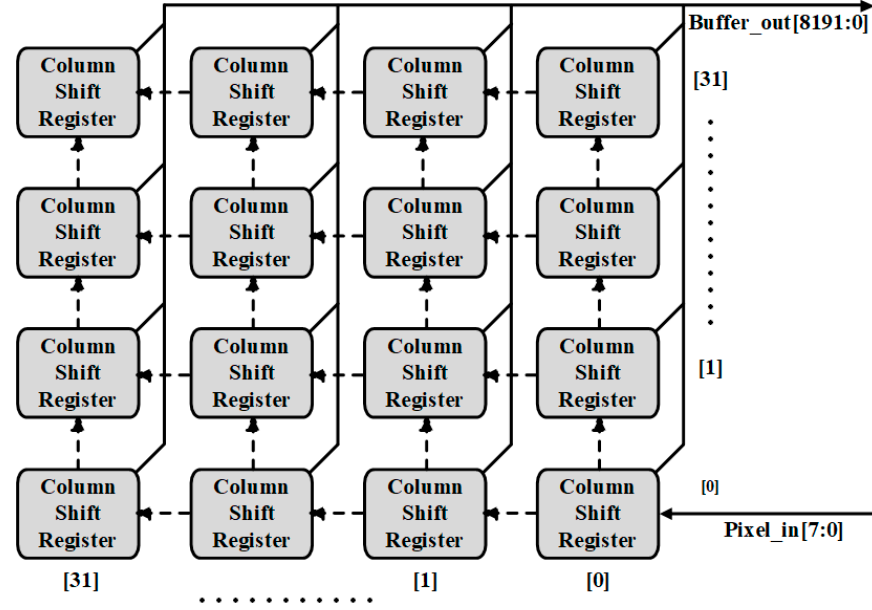
Figure 6. Window shift structure.